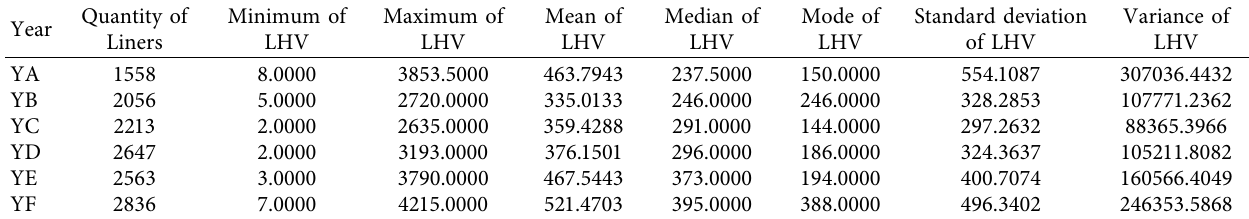
Figure 3: Distribution preliminary sketch of calling liners handling volume. Table 1: Distribution characteristics of LHV for domestic trade routes (unit: TEU).